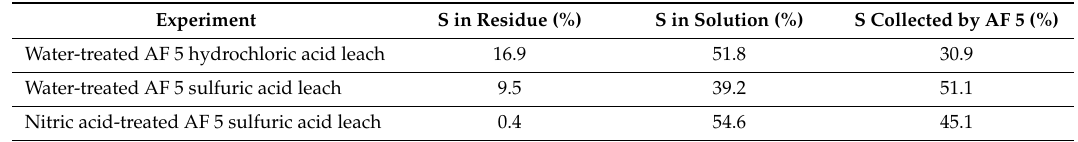
Table 6. Sulfur balance of the leaching